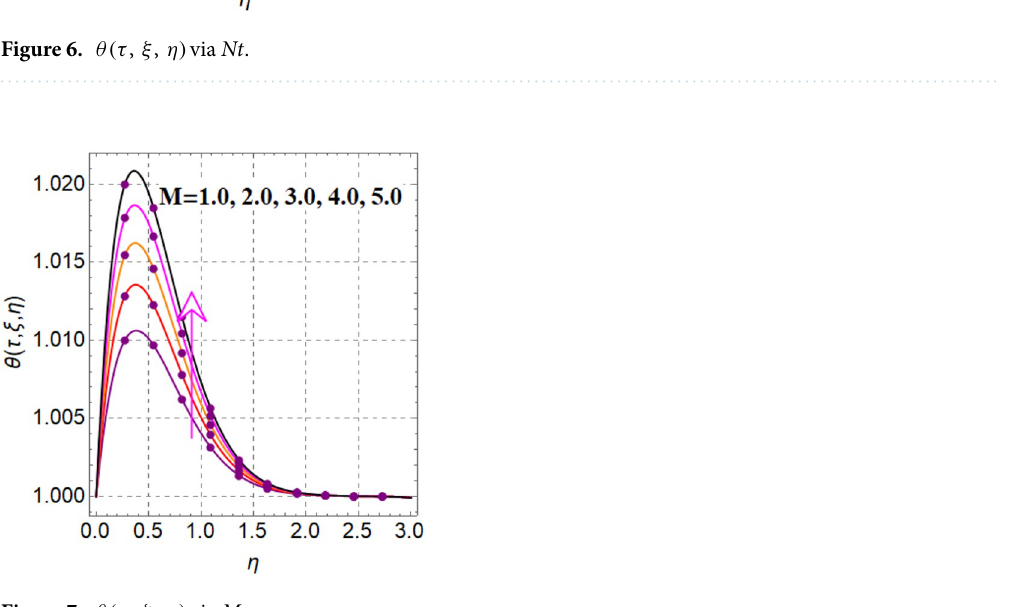
Figure 7. θ(τ , ξ , η) via M